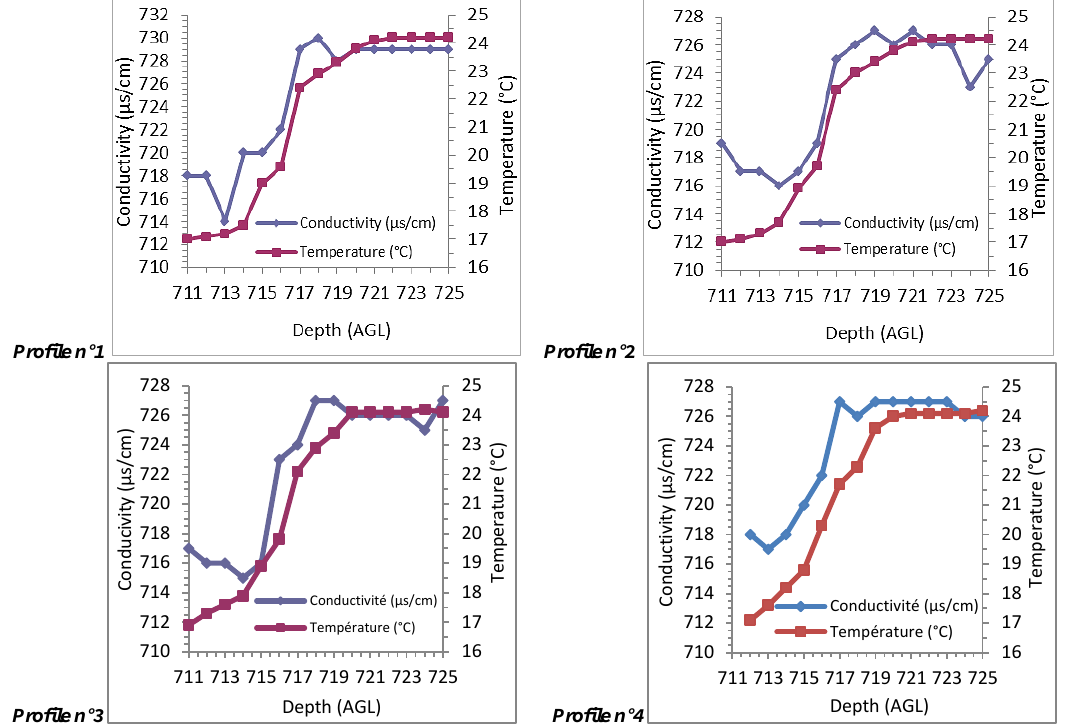
Figure 16. Variation of couple representing the conductivity and the temperature as a function of the water depth at the different